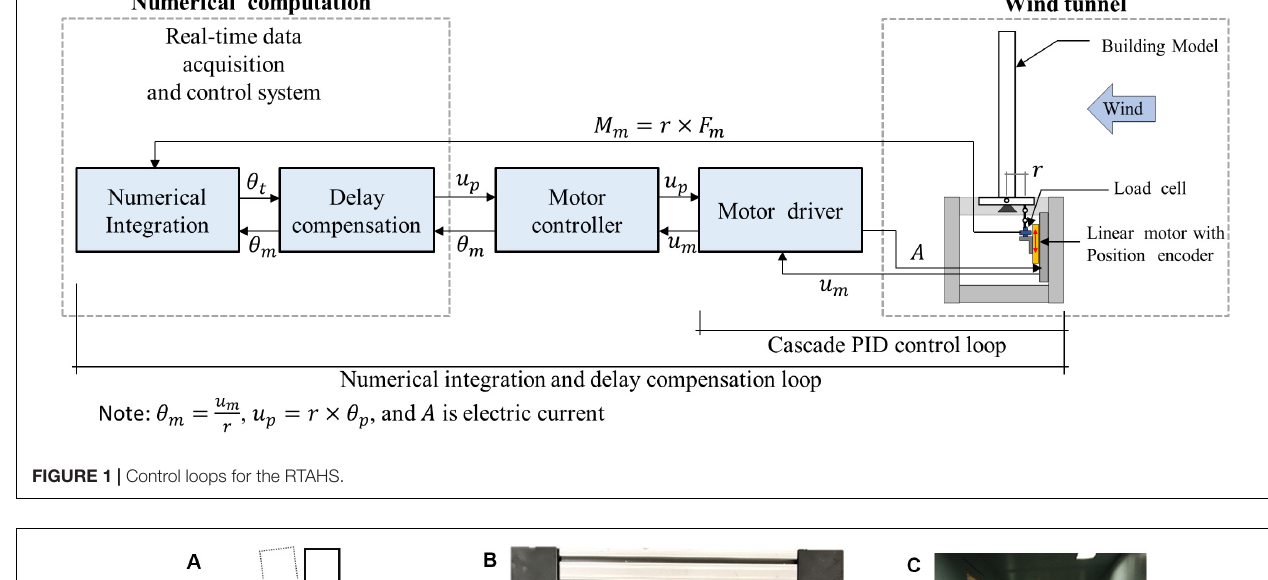
FIGURE 1 | Control loops for the RTAHS.